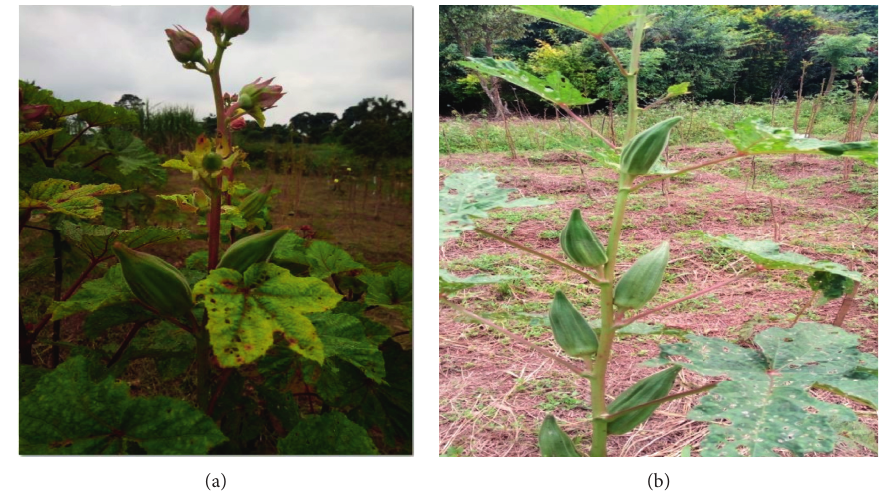
Figure 4: Okra plant at fruiting stage on the field.